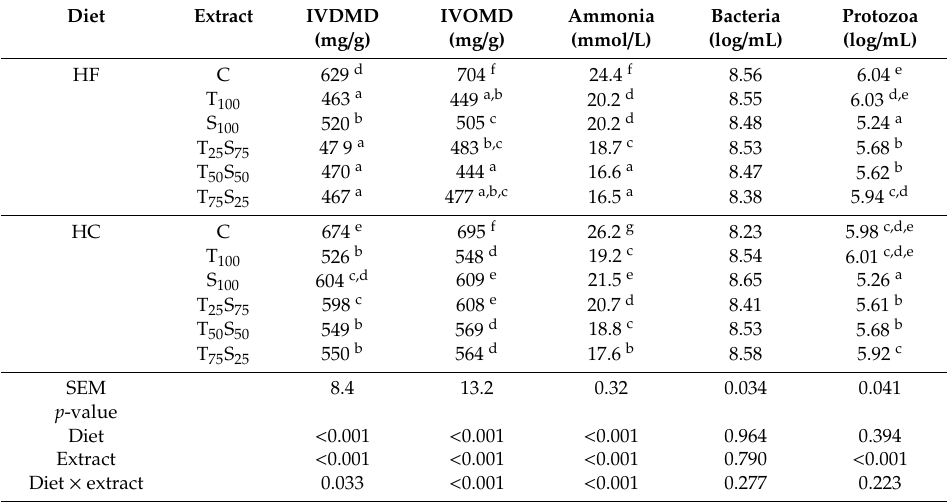
Table 3. In vitro dry matter and organic matter degradability (IVDMD and IVOMD, respectively), ammonia concentration, log bacteria, and log protozoa counts measured after 48 h of incubation with the HF or HC diets, supplemented with varying proportions of plant extracts rich in T and